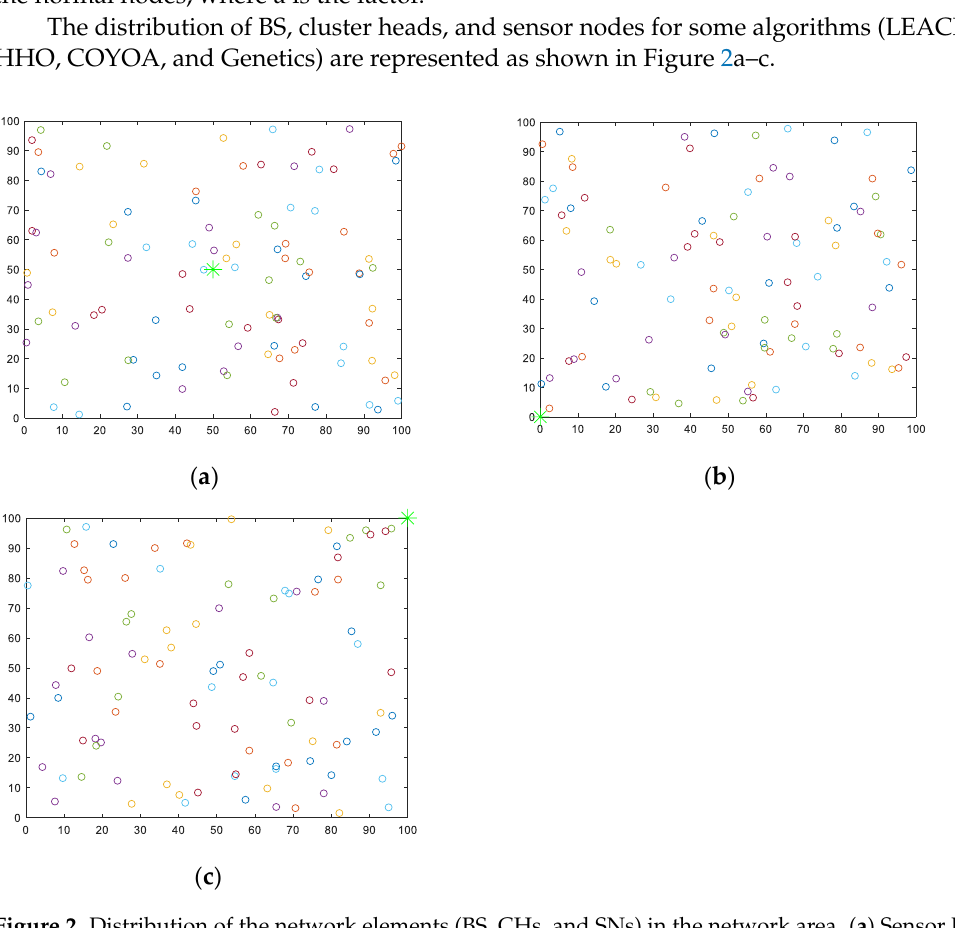
Table 1. List of simulation parameters for the proposed algorithm.